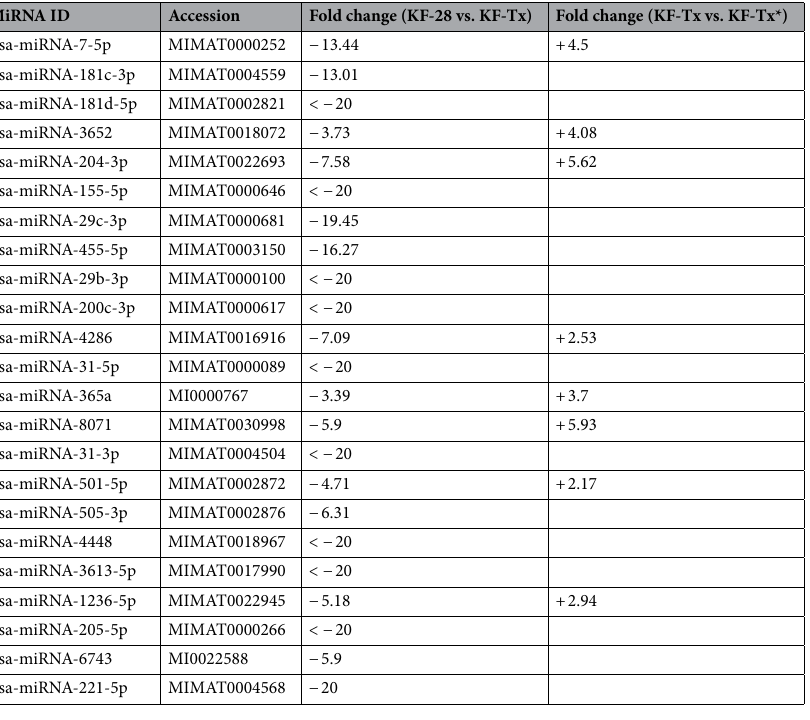
Table 1. Microarray data of differentially expressed miRNAs. KF-Tx* KF-Tx cells treated with the epigenetic modulators 5 ′ AZA and